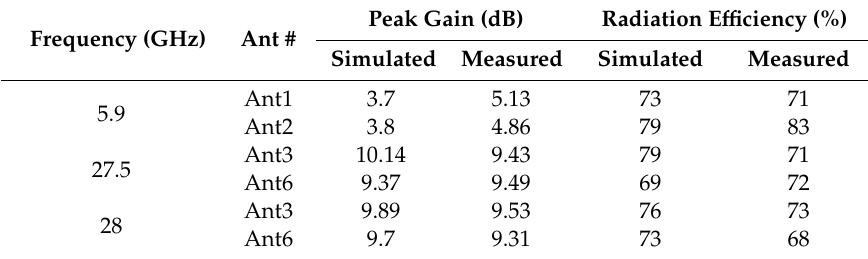
Table 2. Gain and Radiation E ffi ciency of Integrated MIMO Antenna System.